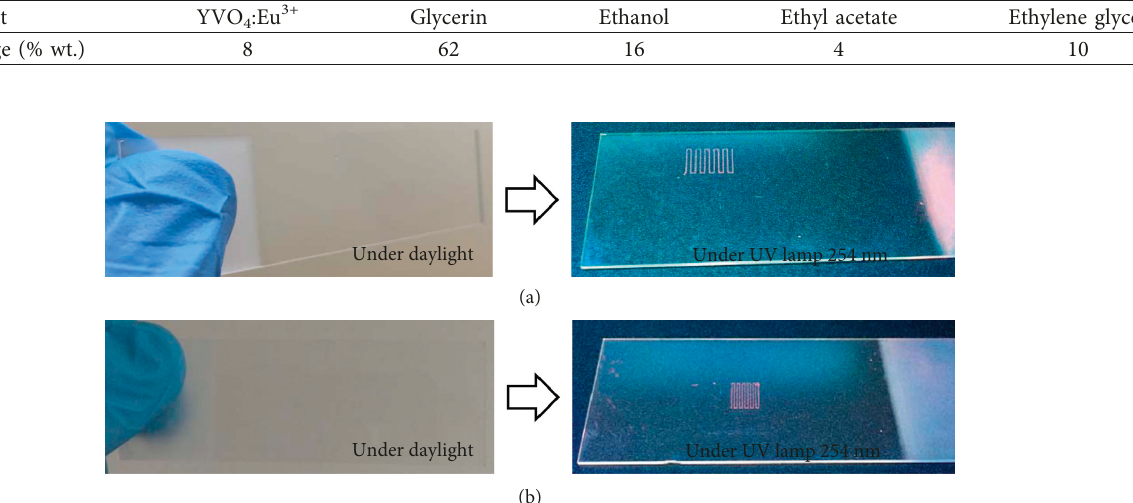
Table 2: Formulation of YVO